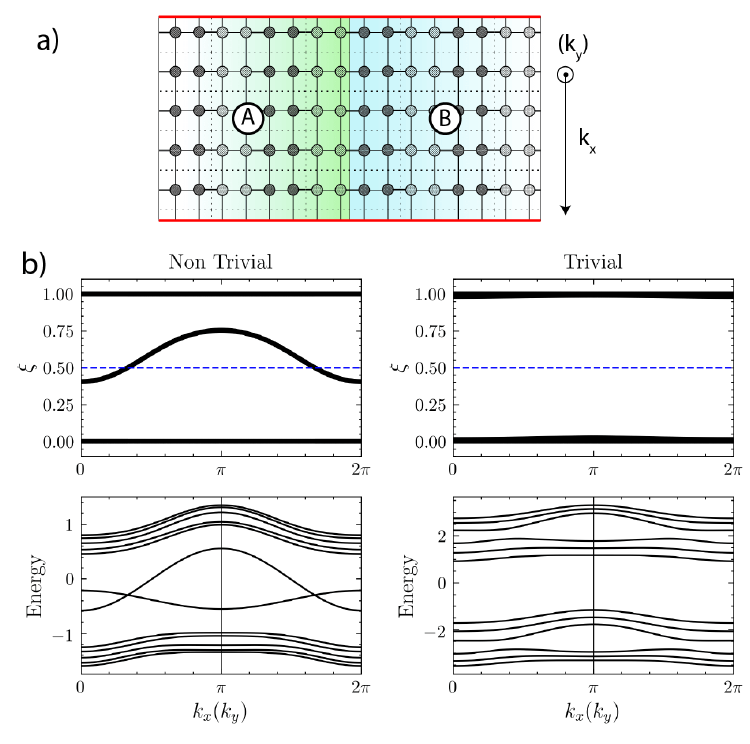
Figure 13: a) Partitioning of the system in two parts for calculating the entanglement spectrum of the reduced 2D system b) (top) entanglement spectrum of the 2D system along the cut (bottom) band structure of 1D ribbon of the corresponding 2D Hamil- tonian showing the edge states for (left) topologically non-trivial and right trivial choice of SSH4